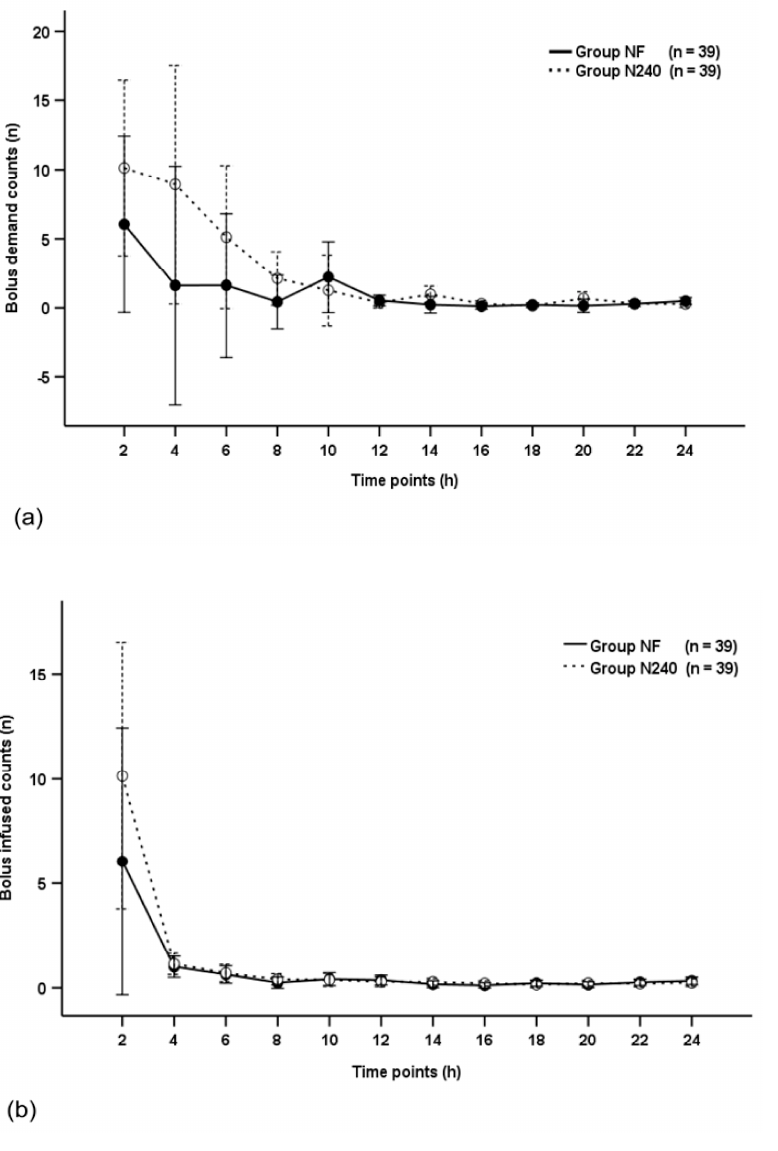
Figure 3. Time-sequential changes of bolus demand counts ( a ) and bolus infused counts ( b ). Data points and error bars represent means and 95% confidence intervals, respectively. Group NF, group receiving nefopam-fentanyl polytherapy; Group N240, group receiving nefopam monotherapy.